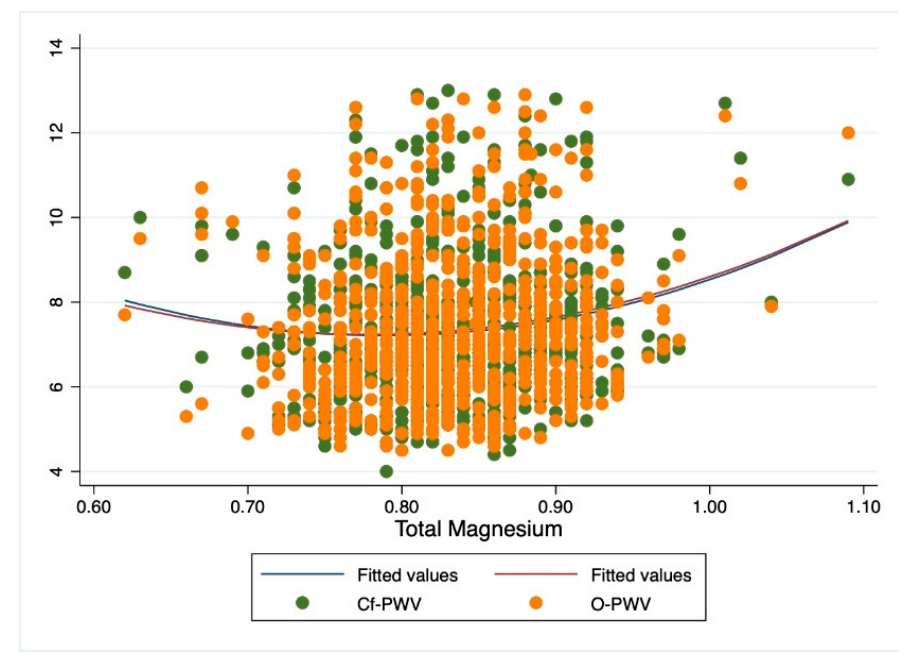
Figure A1. B-Spline function–total magnesium and PWV.